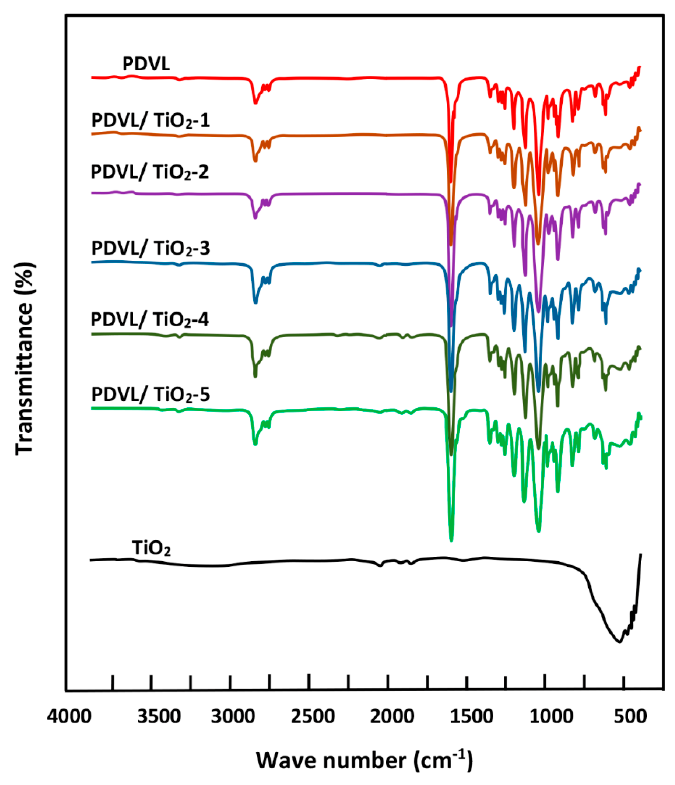
Figure 3. FTIR spectra of TiO 2 nanoparticles, pure PDVL, and PDVL/TiO 2 nanocomposites with different TiO 2 loadings.